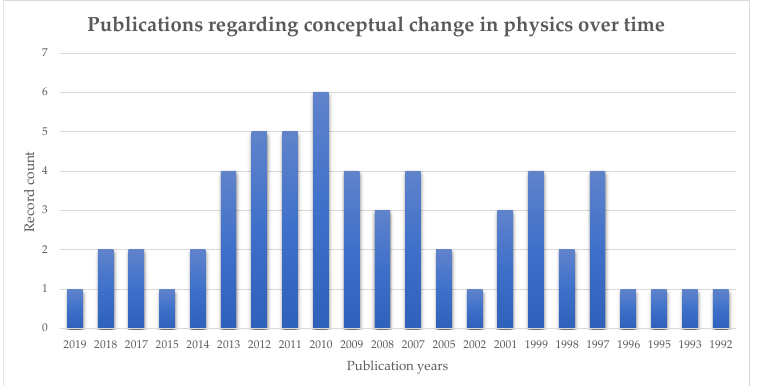
Figure 1. Publications regarding conceptual change in physics over time, using the Web of Science website.